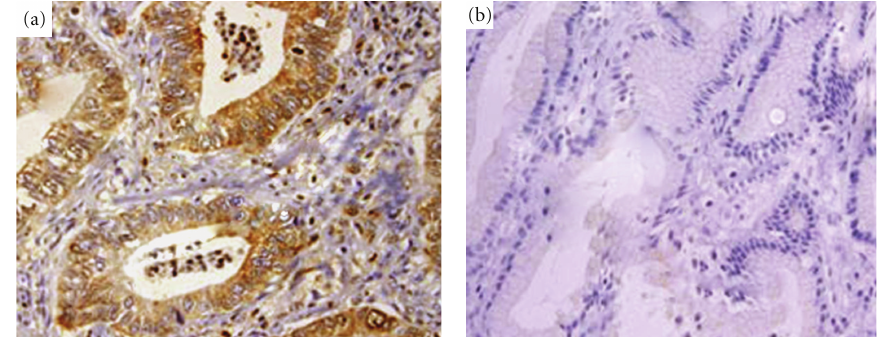
Figure 2: Dickkopf-1-expression by immunohistochemical staining (magnification × 400). (a) Representative Dickkopf-1-positive gastric cancer showing staining mainly in the cytoplasm of tumor cells. (b) Representative Dickkopf-1 negative expression in noncancerous human gastric